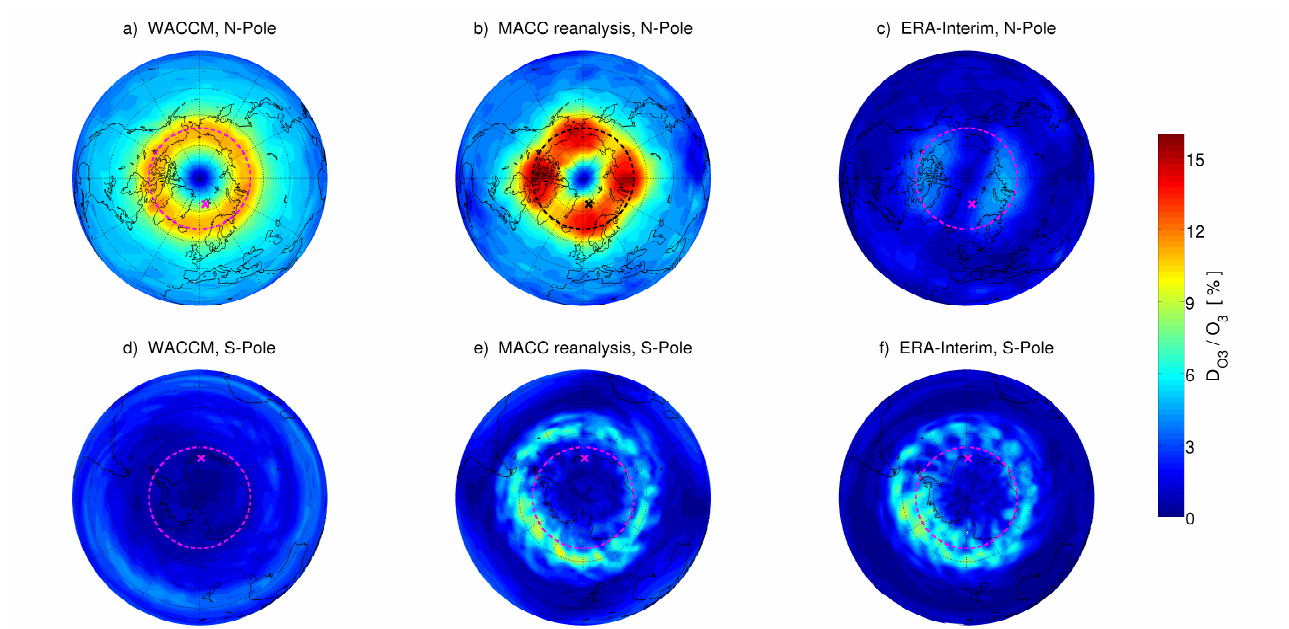
Figure 9. D O /O 3 of WACCM ( a , d ), MACC reanalysis ( b , e ), and ERA-Interim ( c , f ) for June 2012 at 5 hPa. The upper panel 3 is for Arctic summer in the Northern Hemisphere, while the lower panel is for Antarctic winter in the Southern Hemisphere. In the upper panel, the magenta markers refer to the geographical position of OZORAM at Ny-Ålesund, Svalbard. In the lower panel, the marker indicate Troll, Antarctica, where the BAS-MRT has been operating from February 2008 and throughout January 2010. The geographical location of the BAS-MRT is not where the strong effects are indicated by MACC reanalysis and ERA-Interim. The magenta dashed line is the Arctic and Antarctic polar